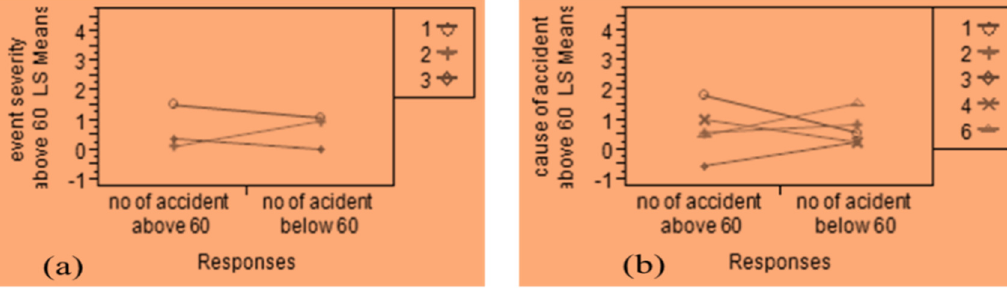
FIGURE.5. DIFFERENCE IN NUMBER OF ACCIDENTS ABOVE 60 WITH RESPECT TO (a) SEVERITY AND (b) CAUSE OF ACCIDENTS